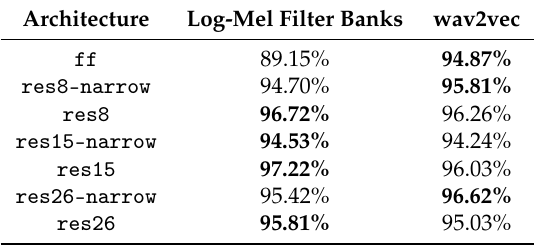
Table 4. Test accuracy on the full Russian dataset.